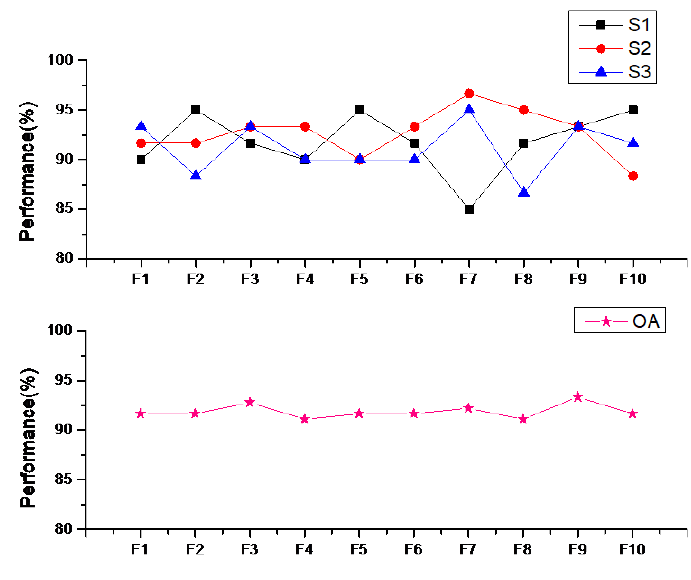
Figure 7. Line chart of performance of SWE-BBO.